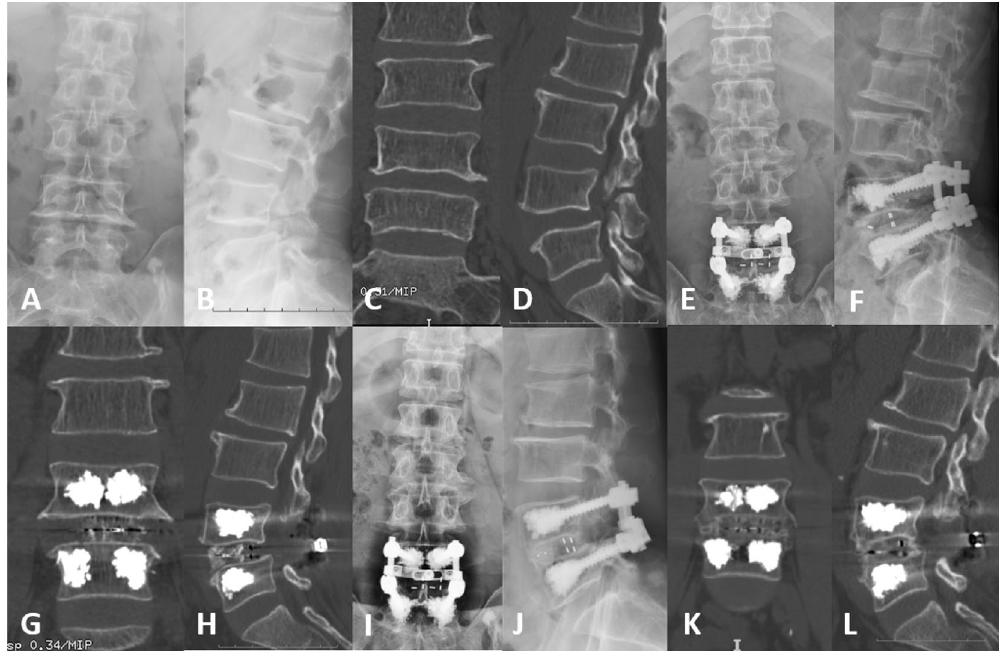
Figure 2. Radiological images of a representative case with PMMA-PS. ( A – L ) A 62-year-old osteoporotic male with isthmic spondylolisthesis in the L4/L5 segments. ( A – D ) Preoperative X-rays and CT showed forward slip of the L4 vertebra and L4 spondylolysis. ( E – H ) Postoperative X-ray and CT showed that the internal fixation position was good and that the bone cement was in the vertebrae. ( I – L ) Postoperative X-ray and CT